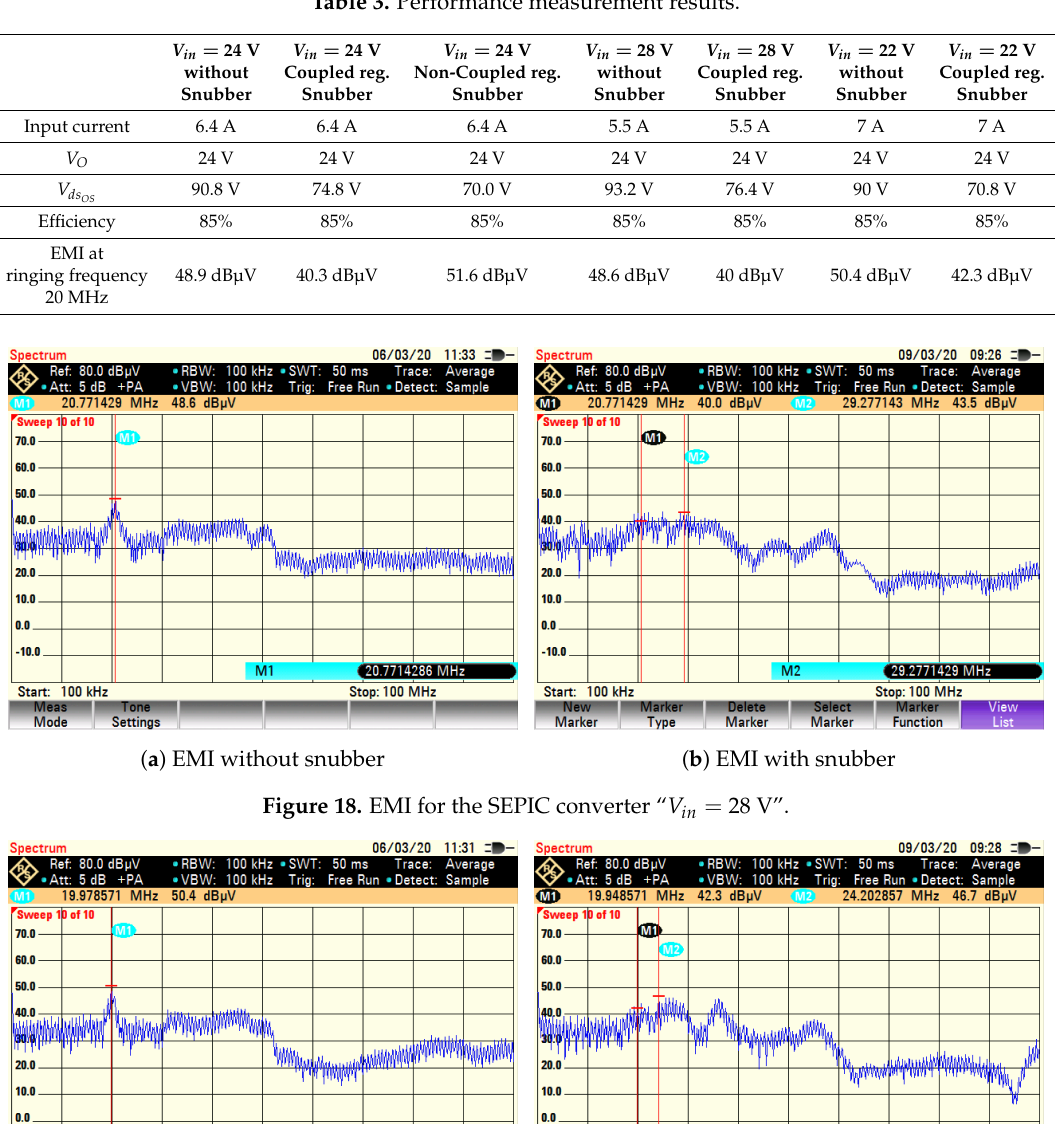
Table 3. Performance measurement results.